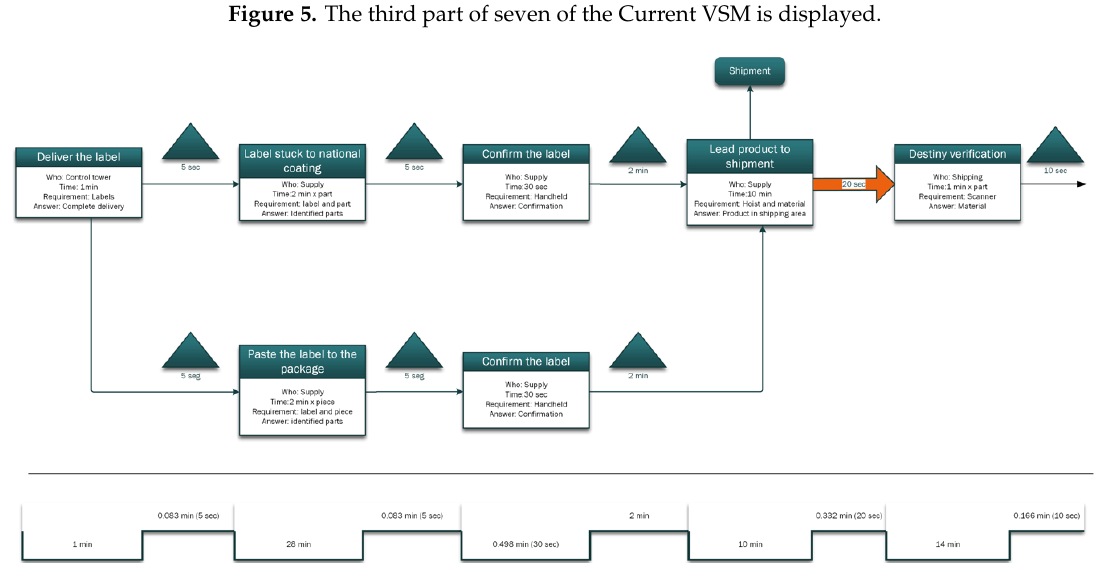
Figure 6. The fourth part of seven of the Current VSM is displayed.